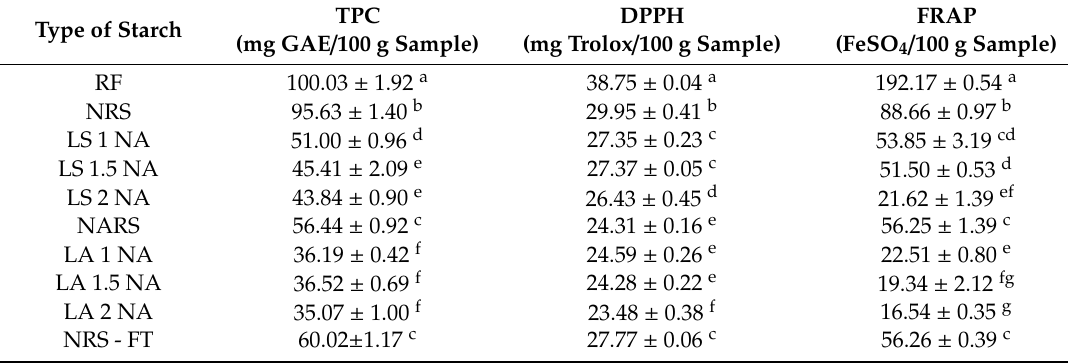
Table 3. Antioxidant properties of the RD 31 rice flour, native starch, and modified starches. Type of